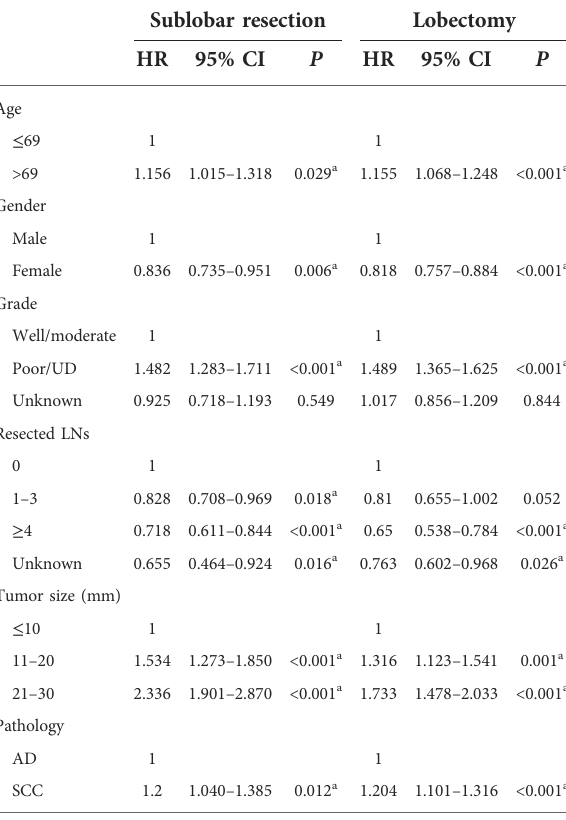
TABLE 6 Multivariate regression analyses for overall survival strati fi ed by surgical